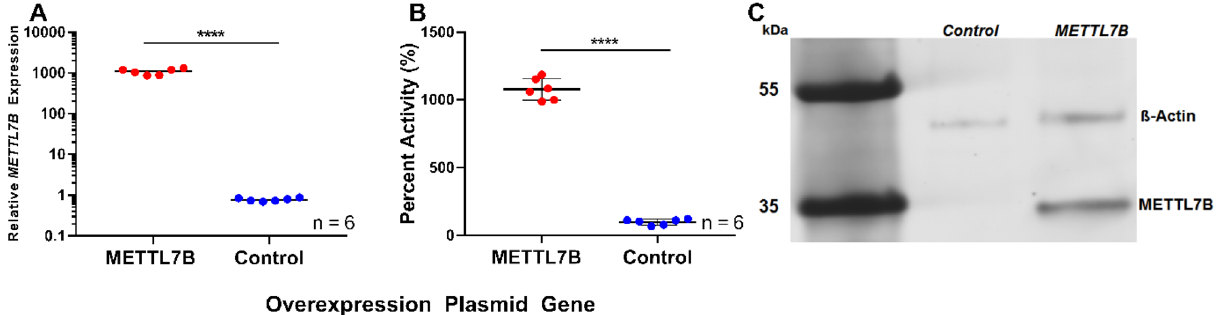
Figure 2. Overexpression of the METTL7B gene in HeLa cells: ( A ) RT-PCR data measuring METTL7B gene expression in HeLa cells treated with a METTL7B overexpression plasmid compared to control cells transfected with an empty expression vector. ( B ) S -methyl captopril measured 24 h following the addition of captopril (500 µM) to HeLa cells treated with METTL7B overexpression plasmid compared to control cells. ( C ) FLAG- tagged METTL7B expression is only observed in HeLa cells treated with the METTL7B overexpression plasmid and not in controls. Western blot using an anti-FLAG antibody confirmed the expression of METTL7B in HeLa cells. Full gel images are available in Supplementary Fig. 1. All data is presented as the mean ± s.d. Individual data points are plotted from two separate experiments. Significance was determined using unpaired two-tailed t test. **** P < 0.0001.